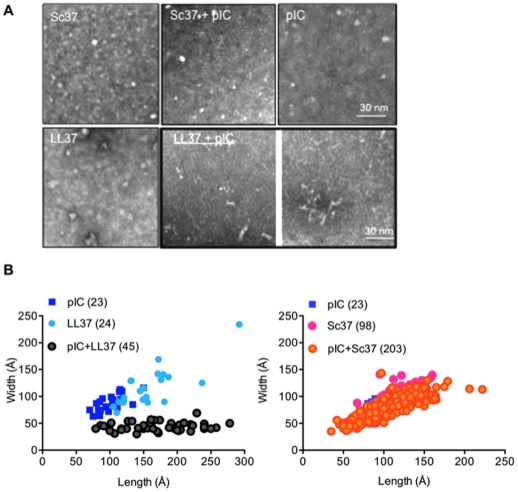
Electron microscopy of unlabeled LL37, Sc37, or poly(I:C) (pIC; 50 µg/ml) either alone or in combination.A) LL37, Sc37 or poly(I:C) was added to a carbon coated copper grid, stained with uranyl acetate and visualized using electron microscopy. The images were taken at a 40,000X magnification using a JEOL transmission microscope. LL37 and Sc37 were present at 10 µM and poly(I:C) was at 50 µg/ml. The bottom middle and right panels show images of LL37 and poly(I:C). B) A plot of the maximal lengths and widths of the subsets of particles present in the electron micrographs. Measurements were made using the toolbox within the EMAN package of software's [66]. Slopes calculated using linear regression with GrapPad Prism software. Slopes for pIC, LL37, Sc37, pIC+Sc37 are all significantly different from 0 (p<0.0005, 23–203 structures). Slope for poly(I:C)+LL37 is not significantly different from 0; p = 0.2; 45 structures). Number of particles measured for each treatment is indicated in parentheses.